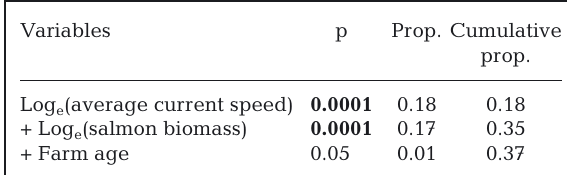
Table 4. Probabilities (p) and proportions (prop.) of variation explained, in sequential tests of combinations of variables as predictors of the average sediment sulfide concentration (log e transformed) in annual monitoring at salmon farms, 2006 to 2009. Tests were performed using the DistLM (distance- based linear models) routine within PERMANOVA+ for PRIMER 6 software. Values in bold were significant (p < 0.05)